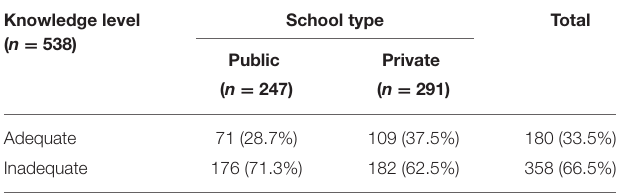
TABLE 6 | Knowledge on harmful health